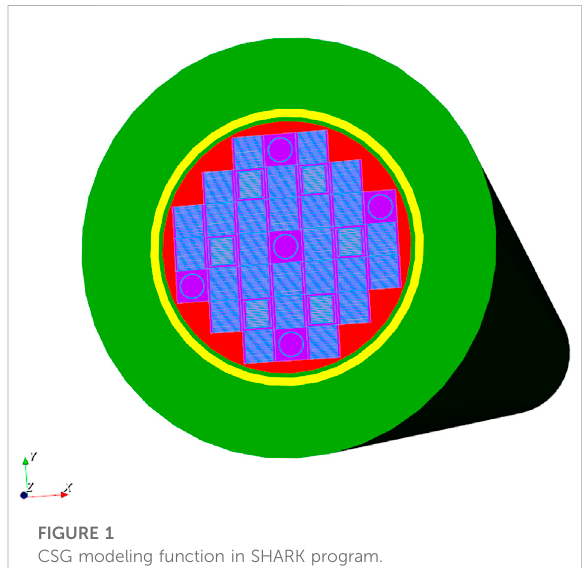
FIGURE 1 CSG modeling function in SHARK